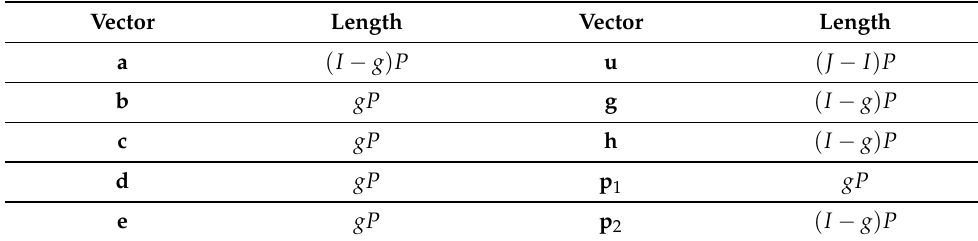
Table 1. Comparison of intermediate computation vector